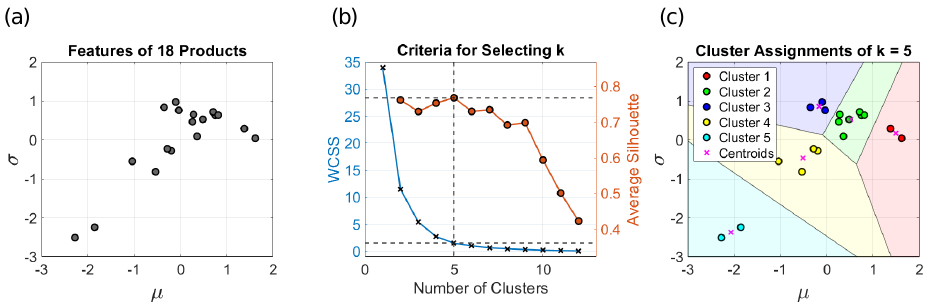
Figure 4. ( a ) The 2–D features where each point represents a type of product; ( b ) From the perspectives of both WCSS and silhouette, it is indicated that k is equal to 5; and ( c ) The clustering result when k is equal to 5.